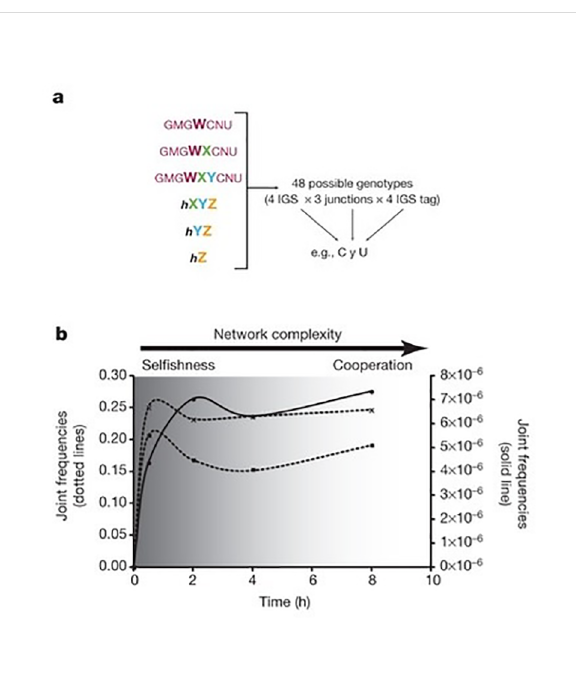
Figure 11: (a) The different combinations of IGS strands, tags and break junction give rise to a total of 48 different pairs. (b) Graph showing the frequency of autocatalytic replicators (dashed, crosses), the two-membered cycles (dashed, dots; ×10) and the three-mem- bered cycles (solid; ×10.000) over time. Note the emergence of the more complex three-membered cycles at later times